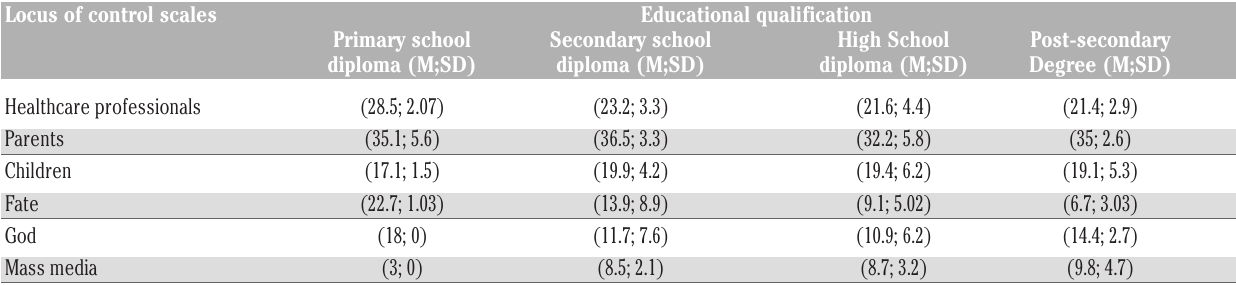
Table 3. Descriptive analysis: locus of control scales (mothers N=60). Locus of control